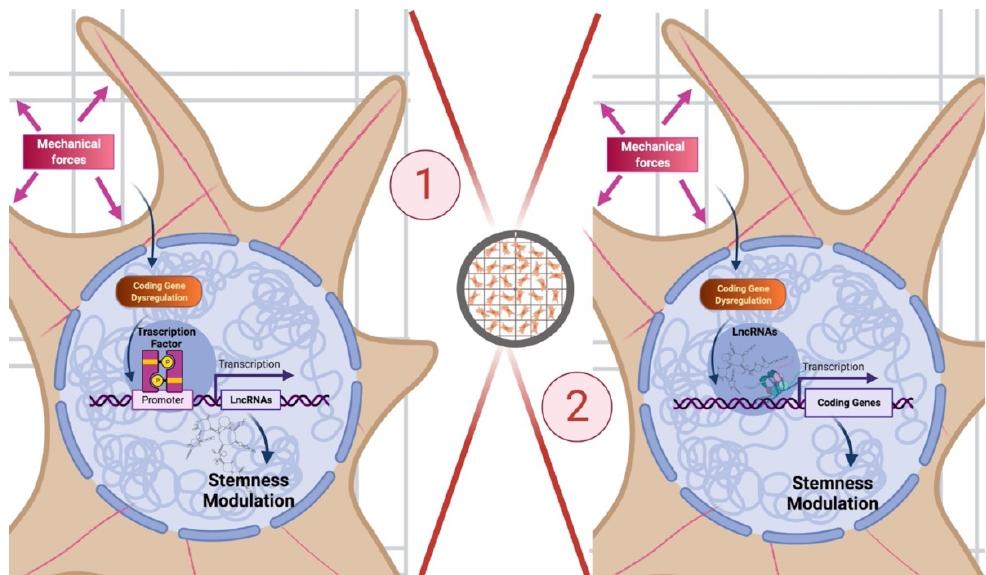
Figure 8. Role of 3D scaffold Nichoid in gene expression and mechanotransduction processes. Enlargement of a cell inside the 3D scaffold Nichoid with two of its possible mechanisms of action. On the left , a first proposed mechanism is that mechanotransduction altered by the 3D scaffold might influence coding genes and specific TFs which in turn control non-coding RNAs expression implicated in stemness and pluripotency. On the right , a second possible hypothesis is that mecha-notransduction altered by the 3D scaffols might affect non-coding genes that themselves influence coding gene expression and consequently stemness and pluripotency phenotype. Created with BioRender.com.